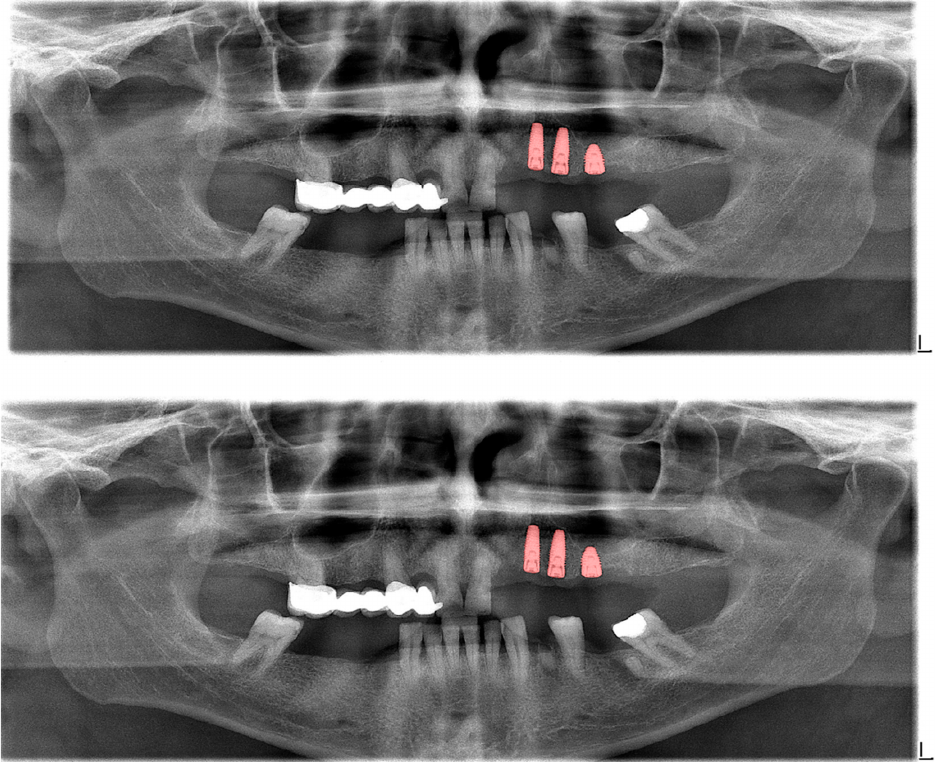
Figure 5. Automatic segmentation of dental implants. Manual segmentation ( upper image ) and automatic segmentation ( lower image ) can be seen above. Diagnostics 2022 , 12 , x FOR PEER REVIEW